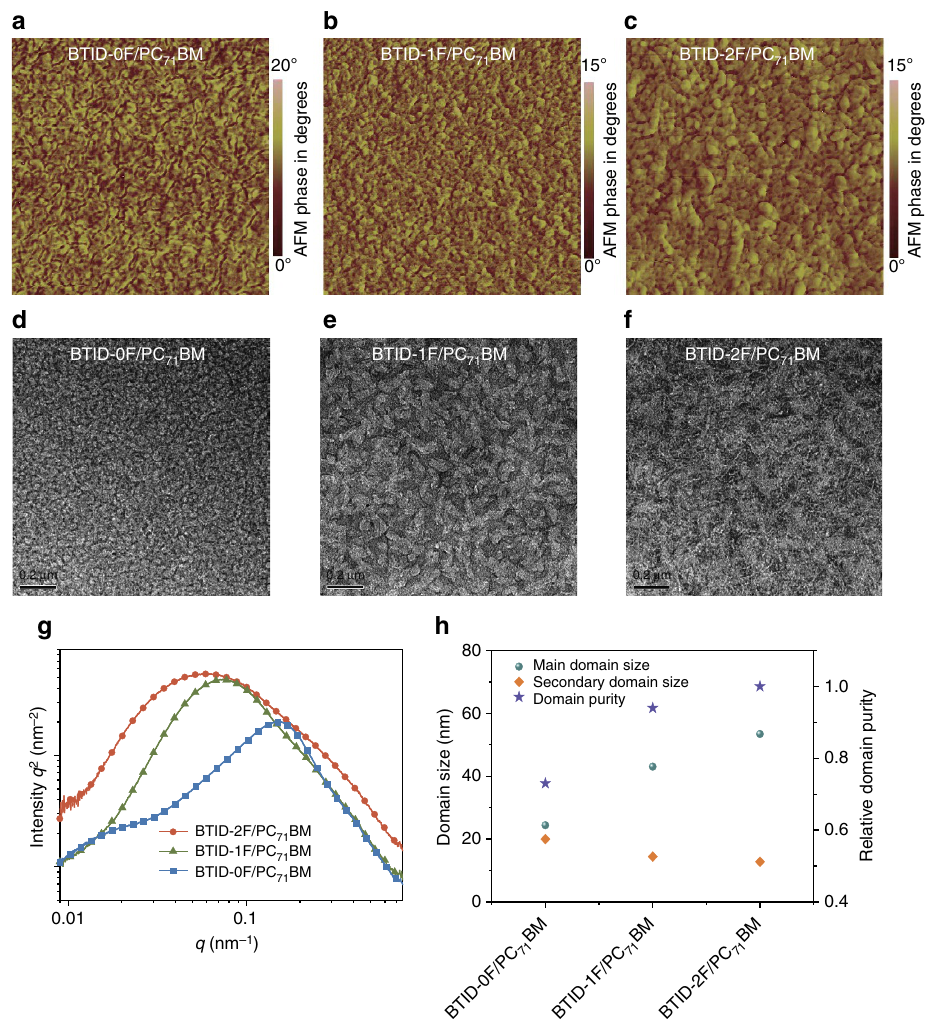
Figure 4 | Lateral morphologies and microstructures of blend films on ZnO/ITO substrates. ( a – c ) AFM phase images; ( d – f ) TEM images; ( g ) RSoXs profiles; and ( h ) relative domain purity and domain